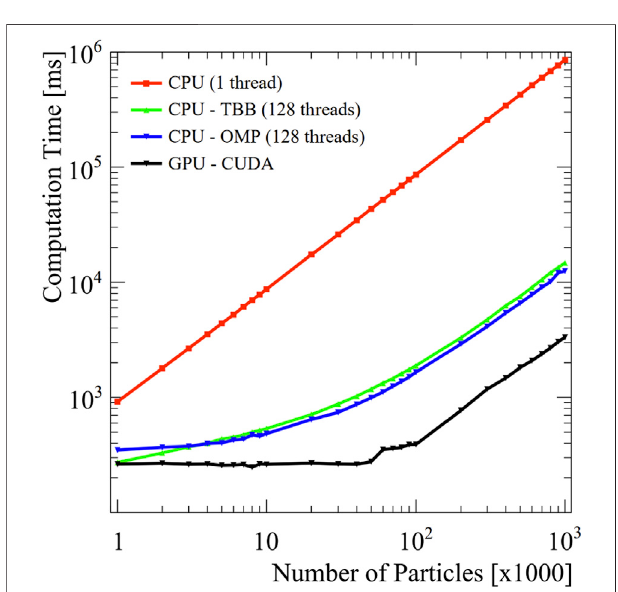
FIGURE 10 | Computing time needed to compute a speci fi c number of